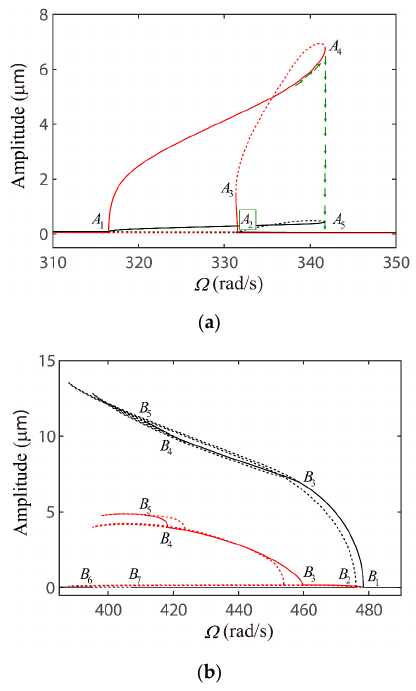
Figure 3. For δ 0 = 1.5 μ m, frequency–response curves of 1/2-order subharmonic resonances of the two degrees-of-freedom of the system, ( a ) in the horizontal and ( b ) vertical directions.